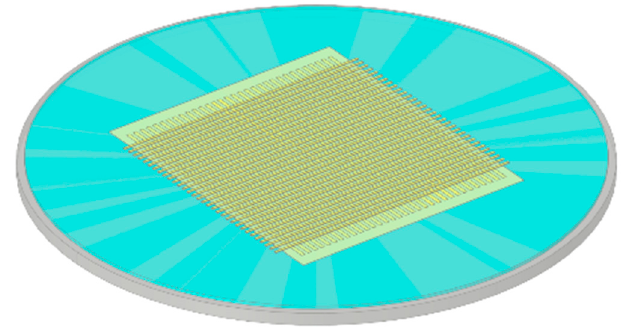
Figure 4. XS anode simulation model established by COMSOL.